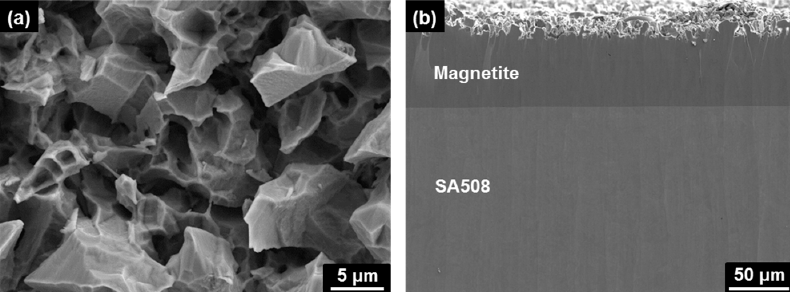
Figure 6. SEM images of the magnetite layer electrodeposited on the SA508 substrate after polarization test in 10% EDTA-based chemical cleaning solution at 93 °C: ( a ) surface, and ( b ) cross- the polarization test in 10% EDTA-based chemical cleaning solution at 93 ◦ C: ( a ) surface, section. and ( b )